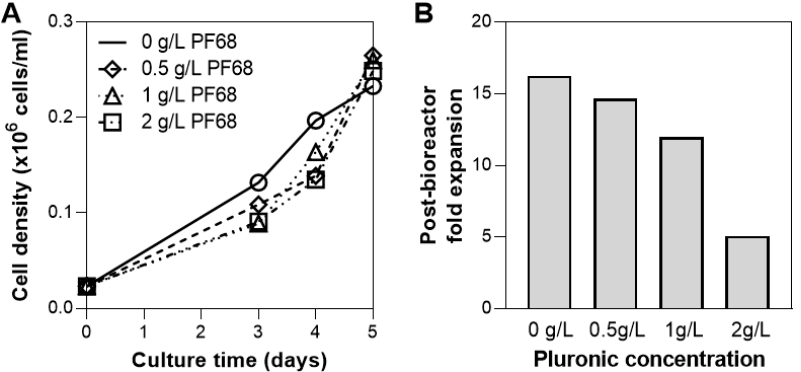
Figure 5. Effect of surfactants on hMSC growth in bioreactor. Addition of pluronic PF68 shows no effect on cell growth ( A ), however a high concentration of PF68 (2 g/L) markedly reduces post-bioreactor expansion ( B ).